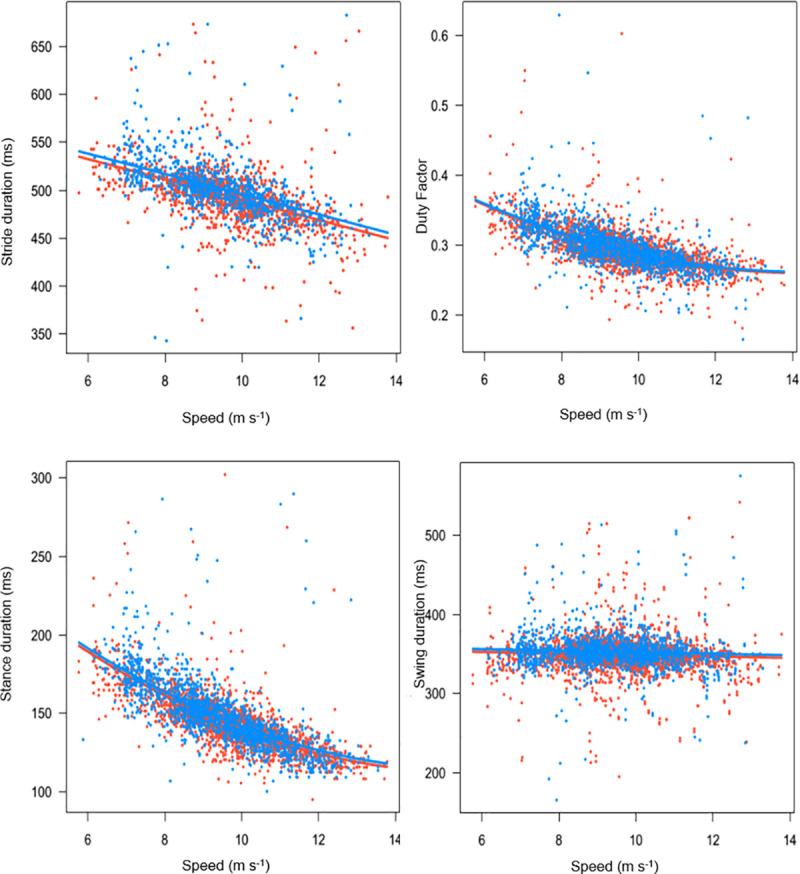
Relationship between speed and stride duration, stance duration, swing duration and duty factor.Red points are inside (left) forelimb and blue points are outside (right) forelimb.